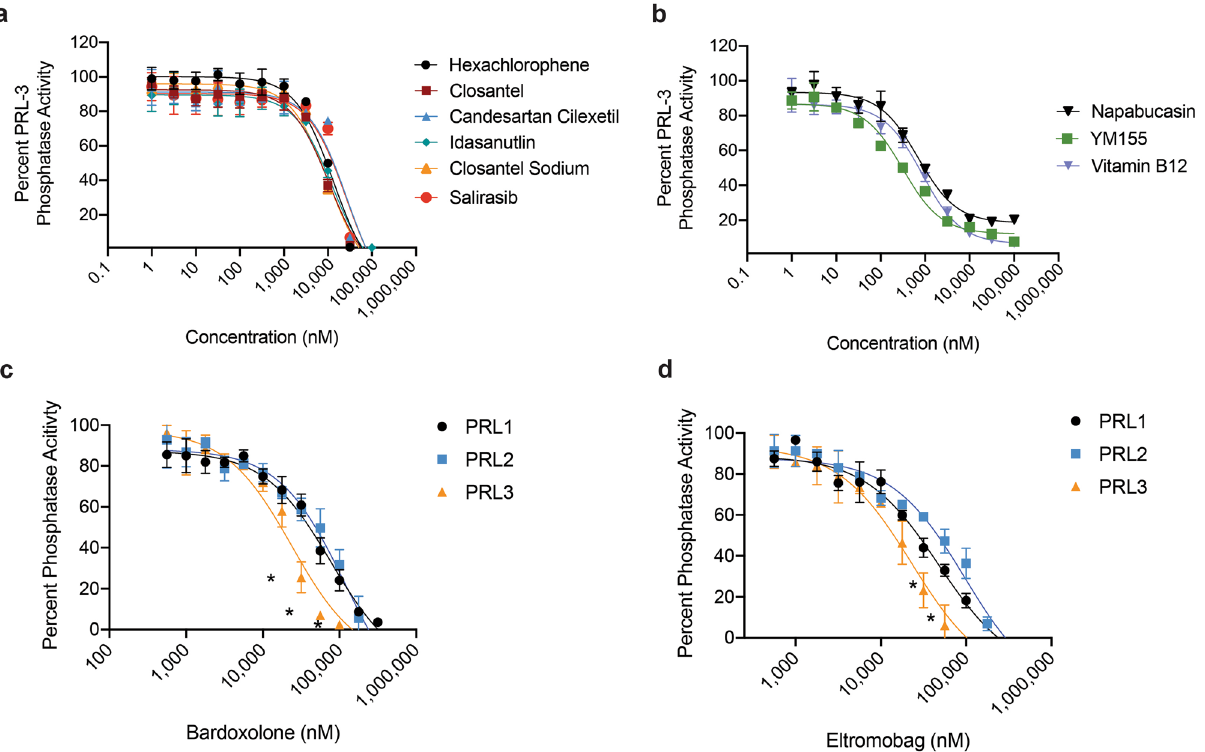
Figure 2. Dose dependent inhibition of PRL family members with FDA-approved drugs. Dose response curves showing DiFMUP phosphatase activity of PRL-3 when treated with doses ranging between 1 nM and 100 µM of each drug. Inhibition of PRL-3 phosphatase activity by the broad PRL family inhibitors are shown, and drugs are subdivided into those with ( a ) high IC 50 values and ( b ) low IC 50 values. A subset of compounds preferentially inhibited PRL-3, including ( c ) Bardoxolone and ( d ) Eltromobag. All assays utilized a final protein concentration of 2.5 µM with DiFMUP concentration at the K M of the protein, and were run in technical duplicates in three independent experiments. Data represent mean phosphatase activity and error bars represent standard deviation between assays. * p < 0.01 comparing PRL-3 phosphatase activity to that of PRL-1 and PRL-2 at the indicated drug dose, using a two-way ANOVA with Dunnet’s correction.